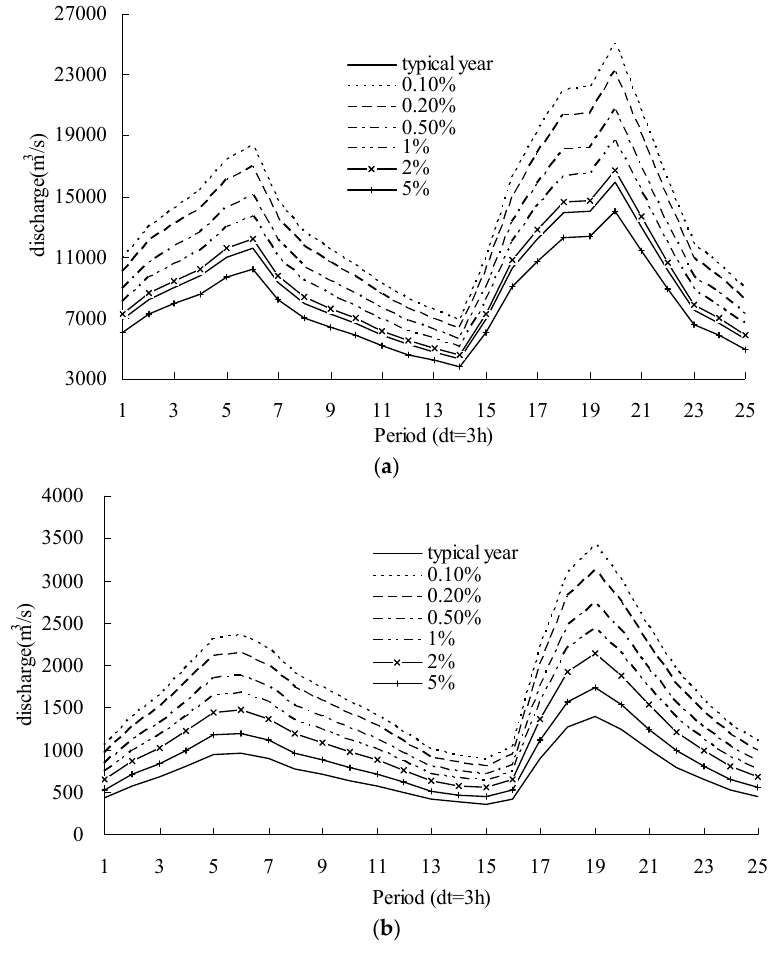
Figure 4. Design inflow hydrographs at two sub-basins for single reservoir. ( a ) Geheyan basin; and, ( b ) Ge-Gao inter-basin.